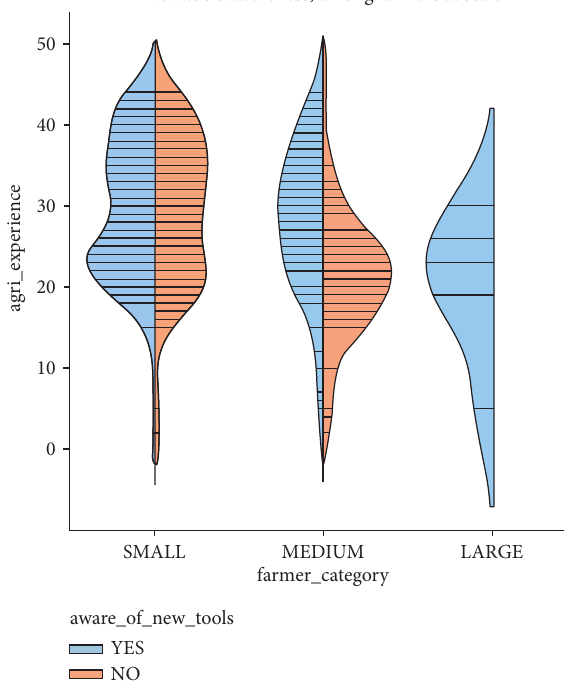
Figure 16: New tools awareness with farmers’